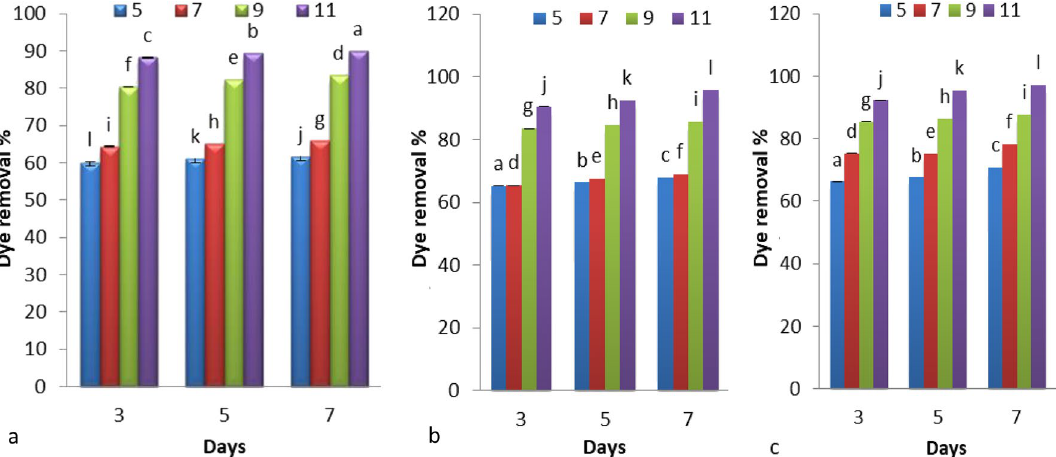
Figure 3. Effect of different pH levels on the Disperse orange 2RL (20 ppm) removal percentage by microgreen alga S. obliquus grown under Mixotroph ( a ), Heterotroph ( b ), Heterotroph supplemented with glucose ( c ). Par represent standard error, different letters clear the significant result.